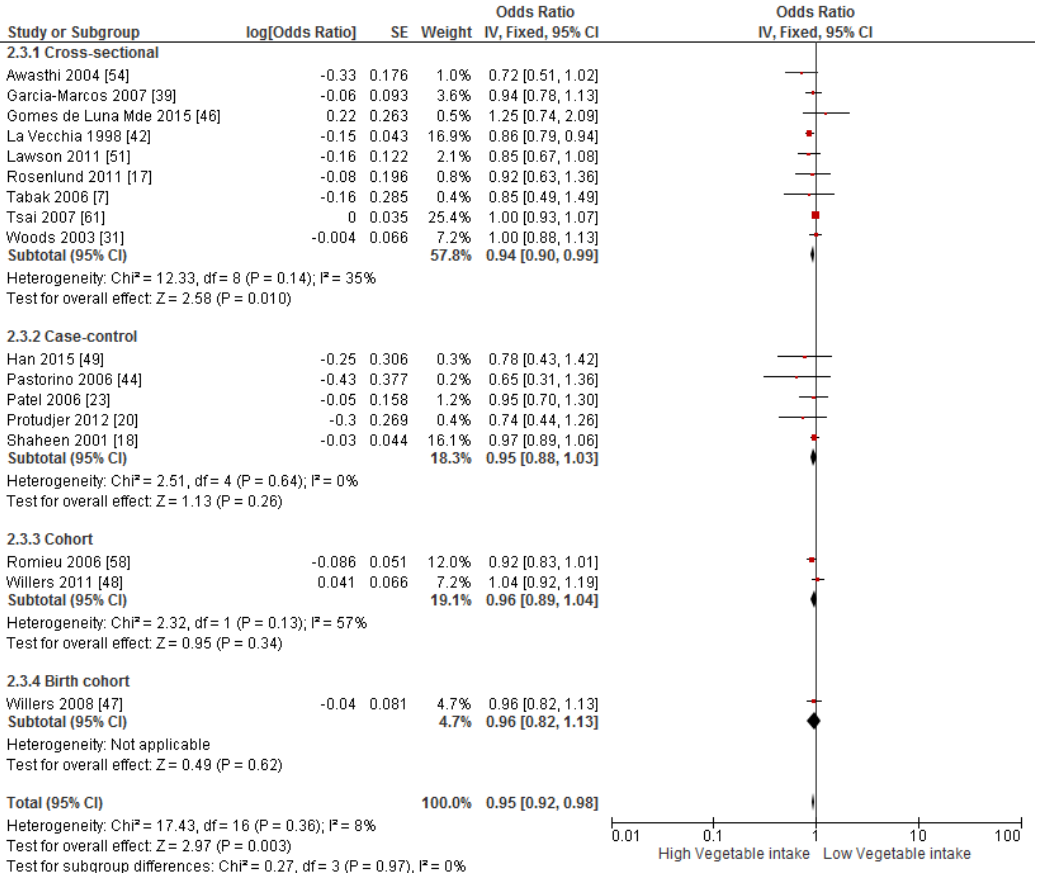
Figure 4. Meta ‐ analysis of the association between fruit intake and severity of asthma.